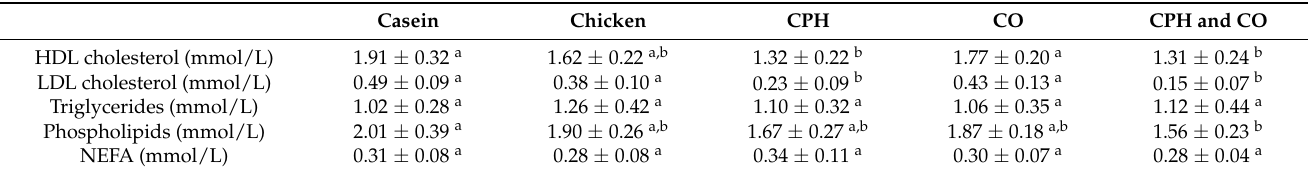
Table 4. Plasma lipid levels in Wistar rats fed high-fat diets chicken fillet, chicken protein hydrolysate (CPH) or chicken oil for 12 weeks 1 .